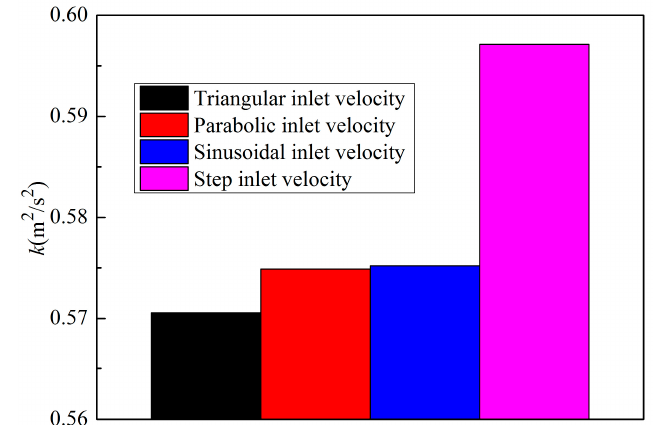
Figure 19. Effect of dynamic inflow type on the mean k of the impingement region during one period, as determined by CFD at u m = 1.25 m/s, A = 0.25 m/s, T = 0.4 s, L/D = 4 and ∆ (cid:2030) = T /2 .